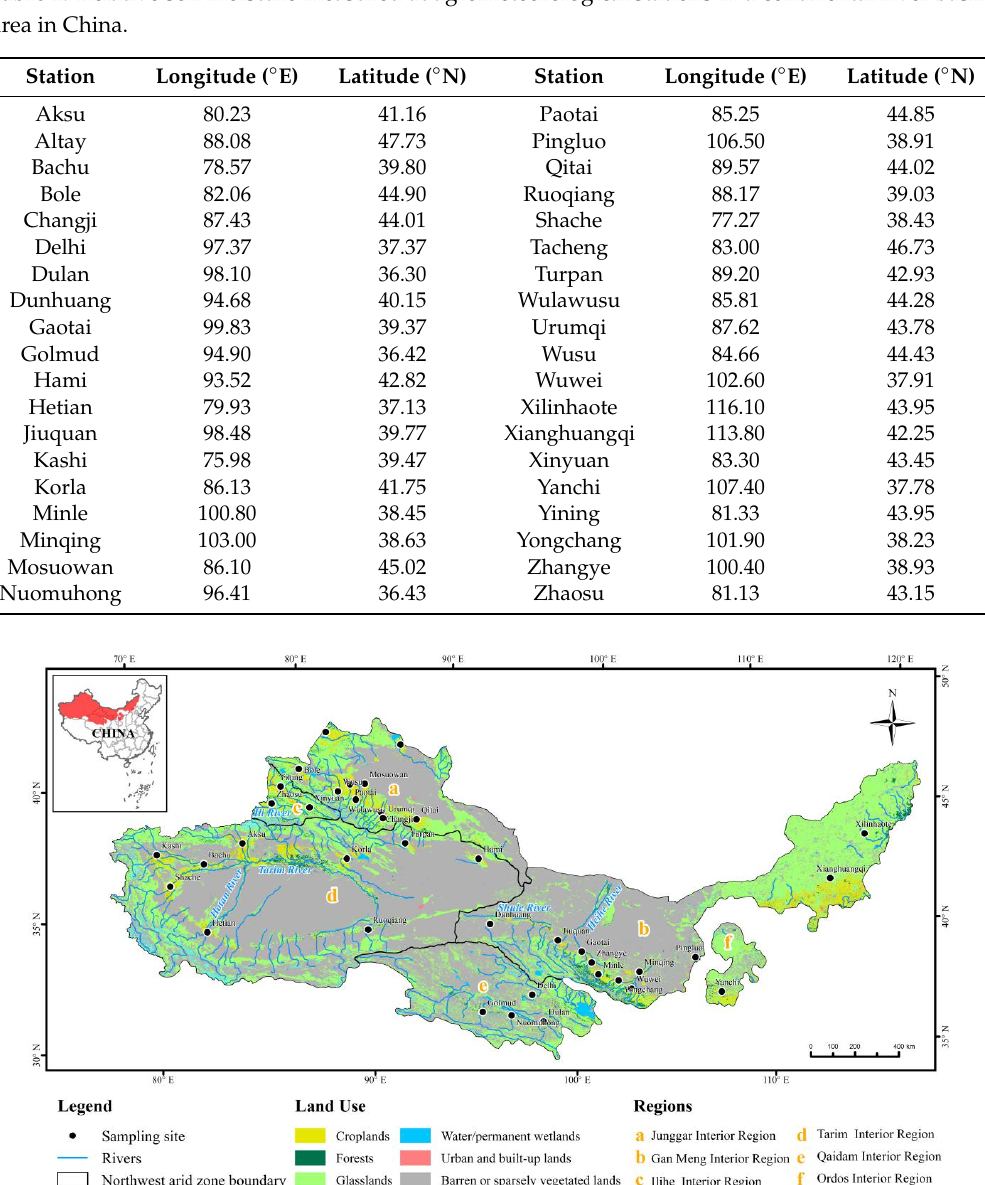
Figure 1. Spatial distribution of soil moisture recording stations in the continental river basin